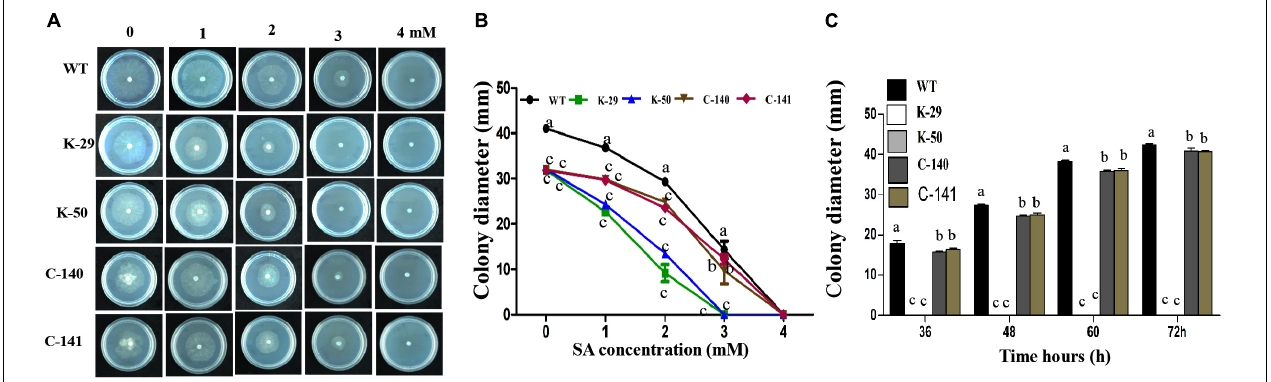
FIGURE 3 | Effects of VpFSTF1 gene deletion on the V. pyri SA stress response. (A) WT, (cid:49) VpFSTF1 , and VpFSTF1 com strains were grown on PDA medium amended with 0, 1, 2, 3, and 4 mM SA and incubated at 25 ◦ C in the dark for 24 h. Representative photographs are shown. (B) Radial growth of the strains on PDA supplemented with different concentrations of SA compared with PDA without SA. Colony diameters were measured at 24 h. (C) Inhibition of colony growth on PDA with 4 mM SA at indicated time points. Colony diameter was measured at indicated time points. Bars indicate the standard deviation of the mean of three replicates. Different letters indicate significant differences ( P < 0.05, ANOVA). The experiment was repeated three times with similar results.